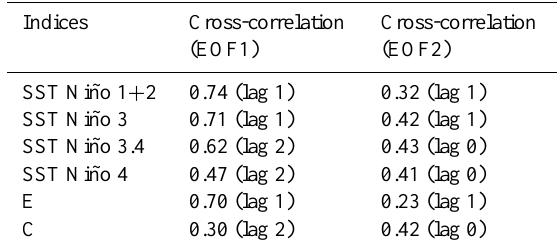
Table 1. Cross-correlation of the EOFs with Ni˜no region SST anomalies (indices), E and C